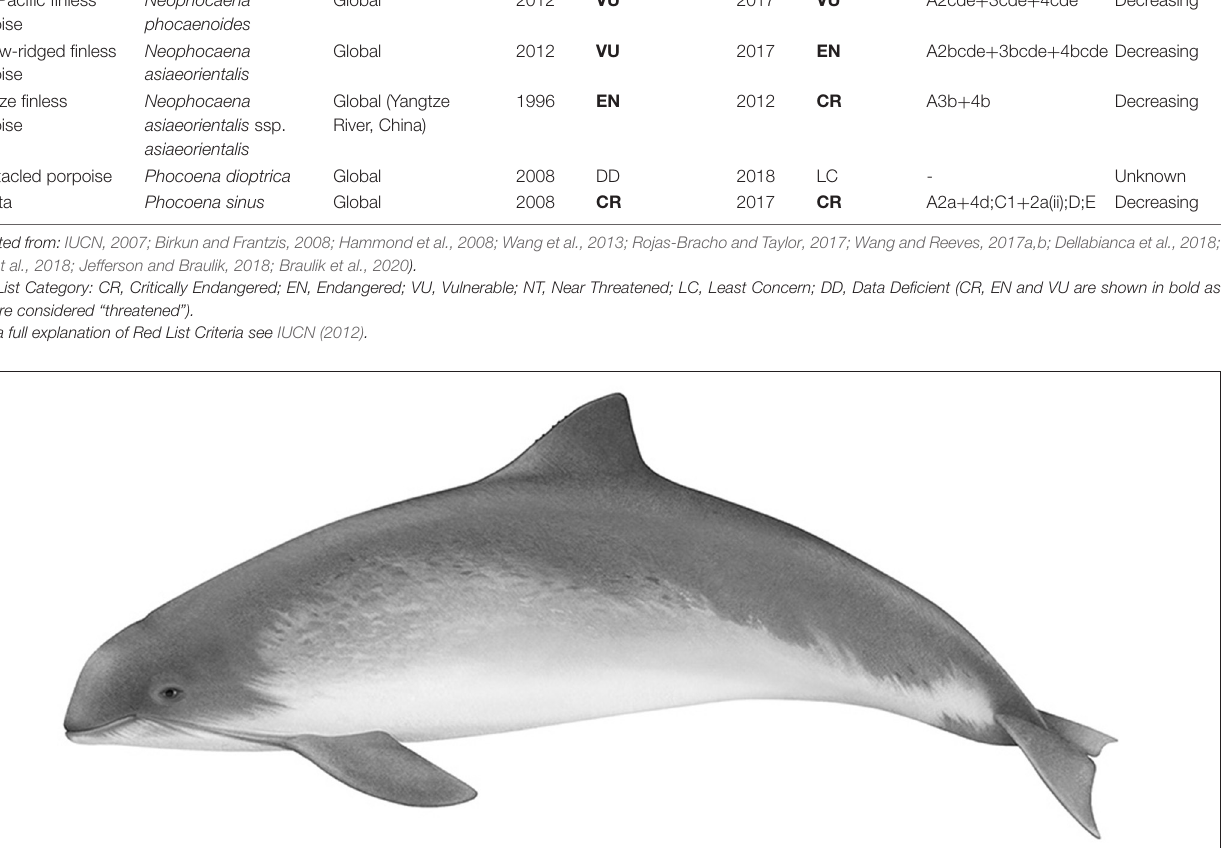
FIGURE 1 | Harbor porpoise (Image by Lucy